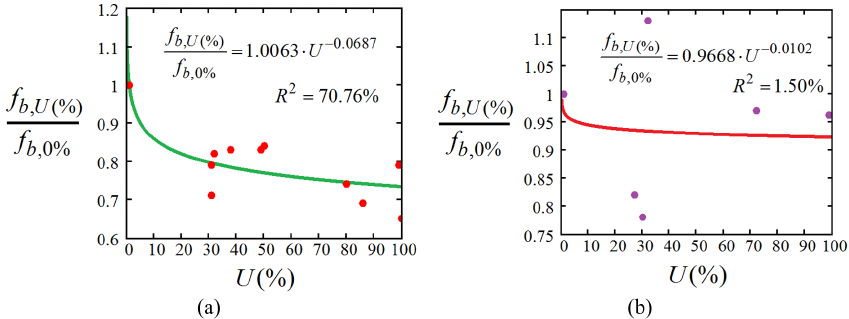
Figure 5. Ratio values between wet and dry compressive strength as a function of relative moisture content considering the grouping of the results of blocks A and C (a) and blocks B (b)